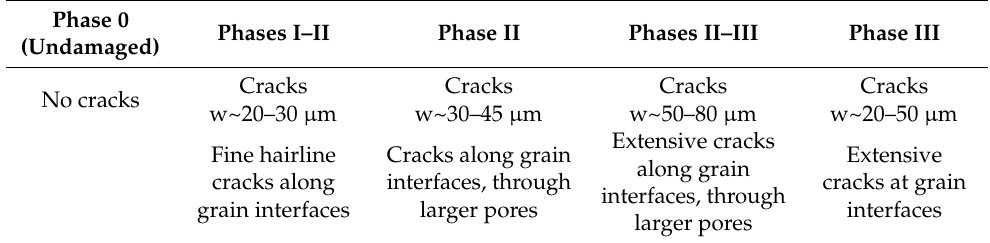
Figure 12. XRCT scan of HPC2-D in phase III. Table 5. Development of the